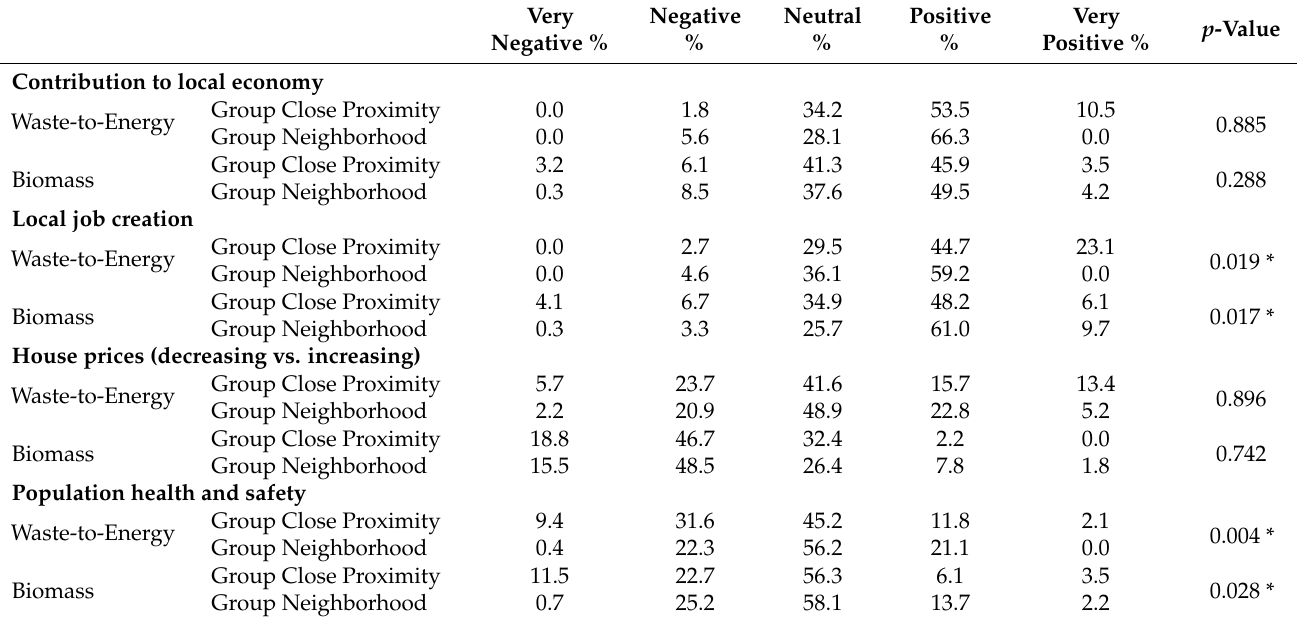
Table A1. Evaluation of experienced impact on local economy and health in the waste-to-energy and biomass neighborhoods—differentiation between people living close (Group Close Proximity) and the ones living further away (Group Neighborhood).